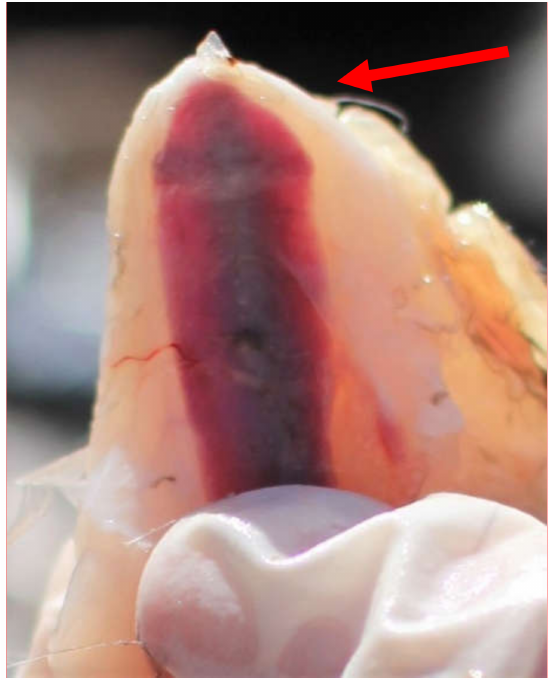
Figure 1. A keel bone with a dark fracture line and slight callus formation (indicated with a red arrow),